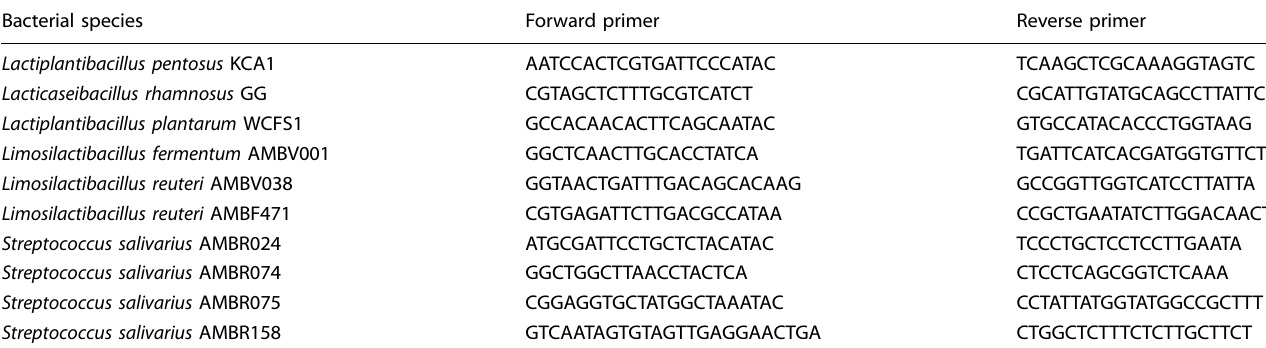
Table 2. Sequences of primers for probiotic detection (5 ’ -3 ’